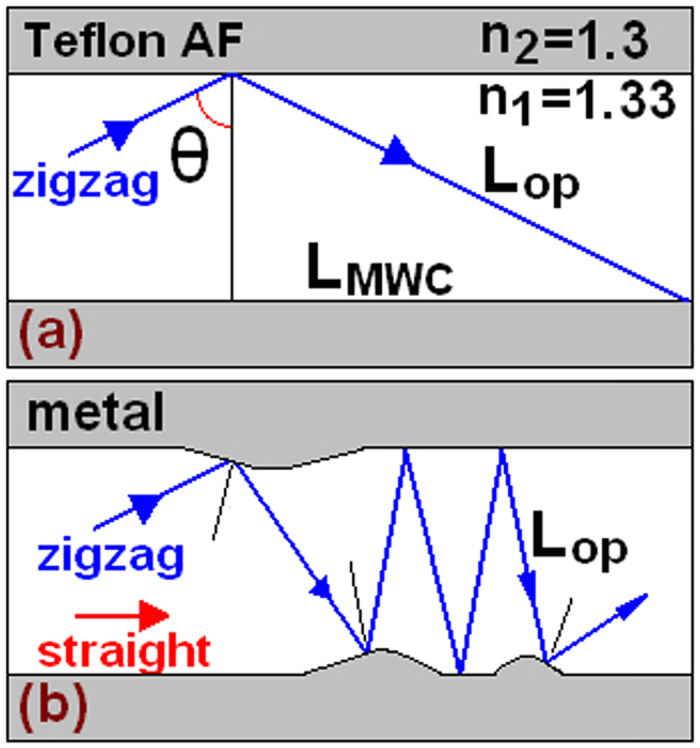
Schematic optical reflection in (a) Teflon AF capillary filled with DI H2O, and (b) MWC.